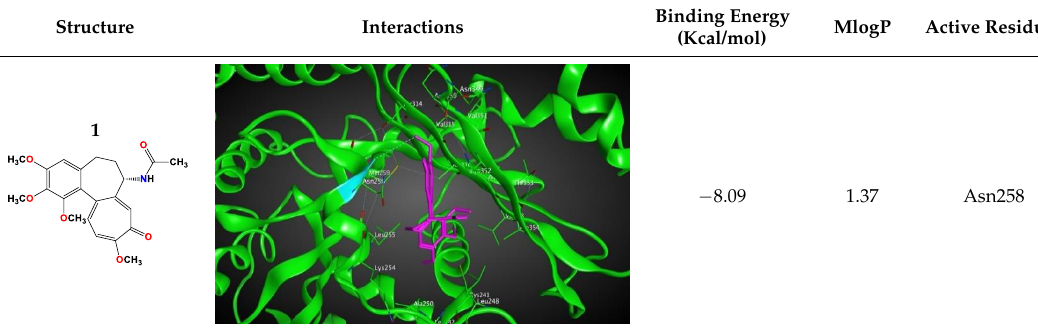
Table 2. Binding energies interactions between eight different colchicine derivatives and βІ tubulin and the estimated Moriguchi octanol-water partition coefficient, MlogP for each colchicine derivative. Structure